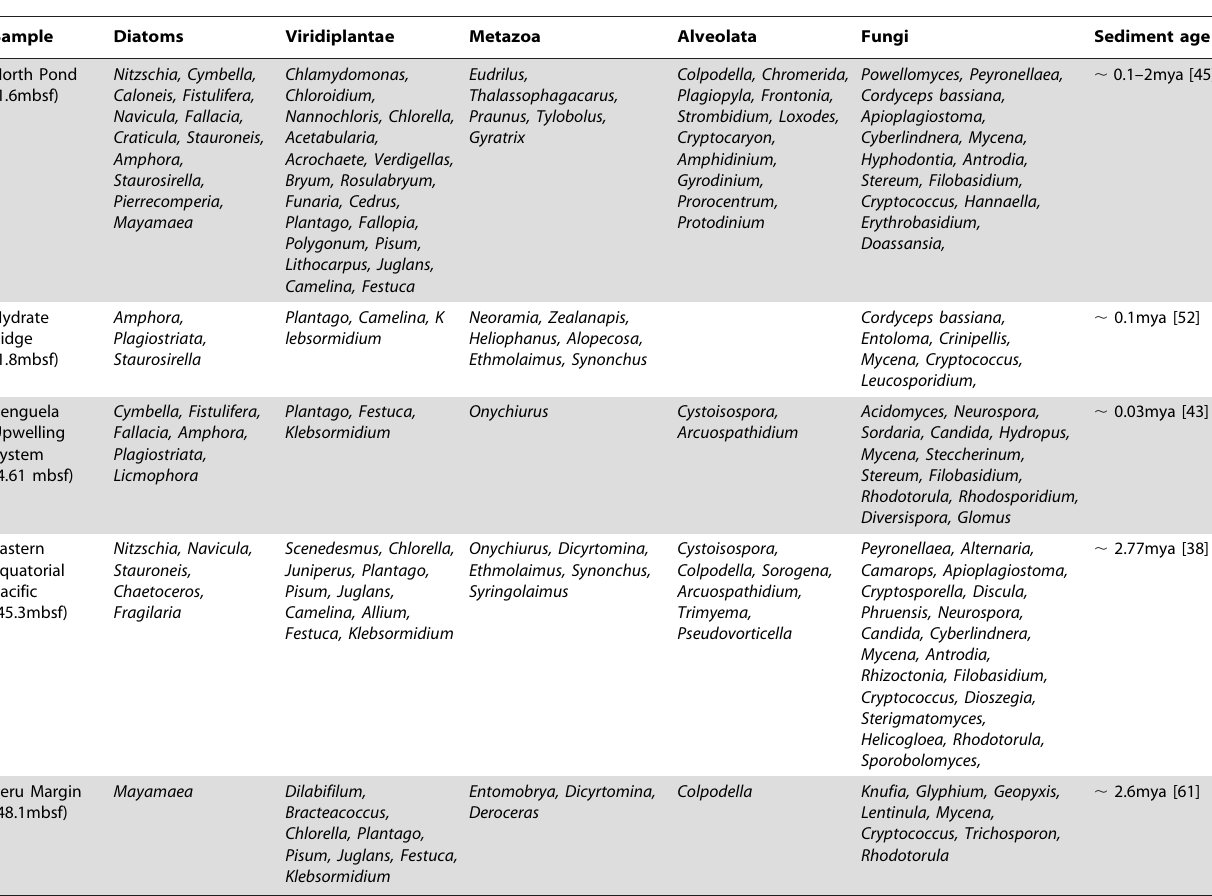
Table 2. Eukaryotic genera affiliated with rRNA sequences detected in subsurface